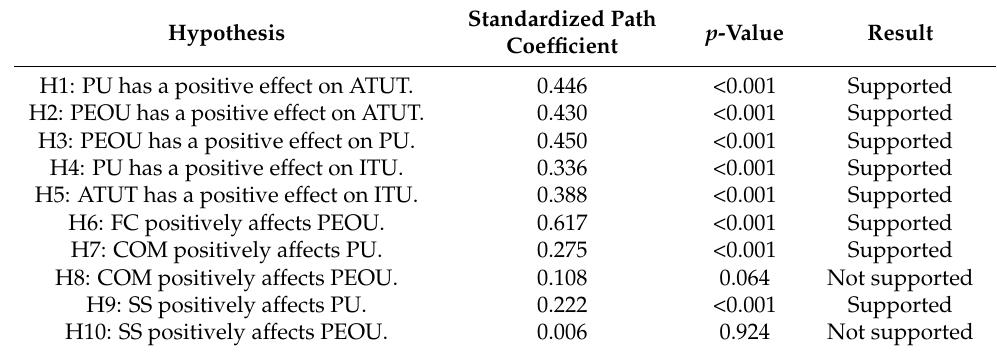
Table 6. Hypotheses testing